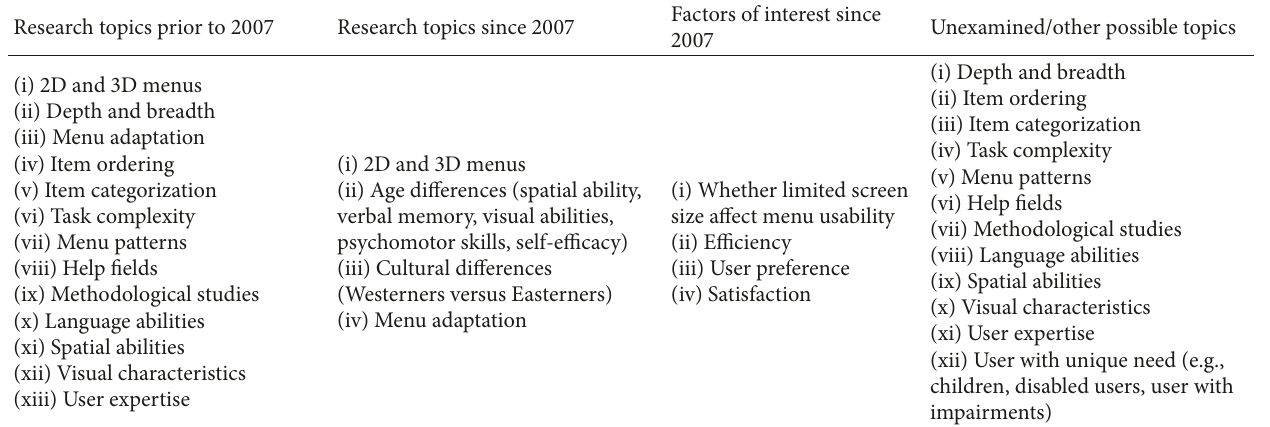
Table 4: Page composition